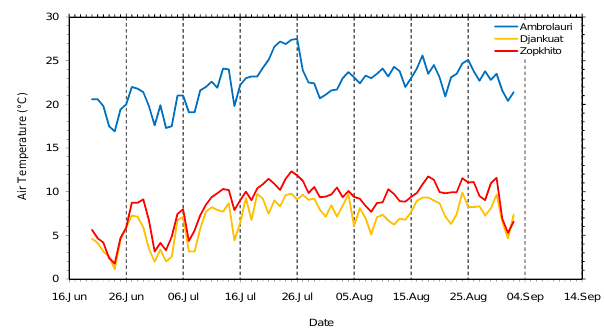
Fig. 5. Comparison of parallel daily mean air temperature mea- surements ( ◦ C) in 2008 on both sides of the Main Caucasus Ridge: at Ambrolauri weather station (550m a.s.l.) and on the Zopkhito Glacier (about 2700m a.s.l.) on the southern slope and on the Djankuat Glacier (2960m a.s.l.) on the northern slope.